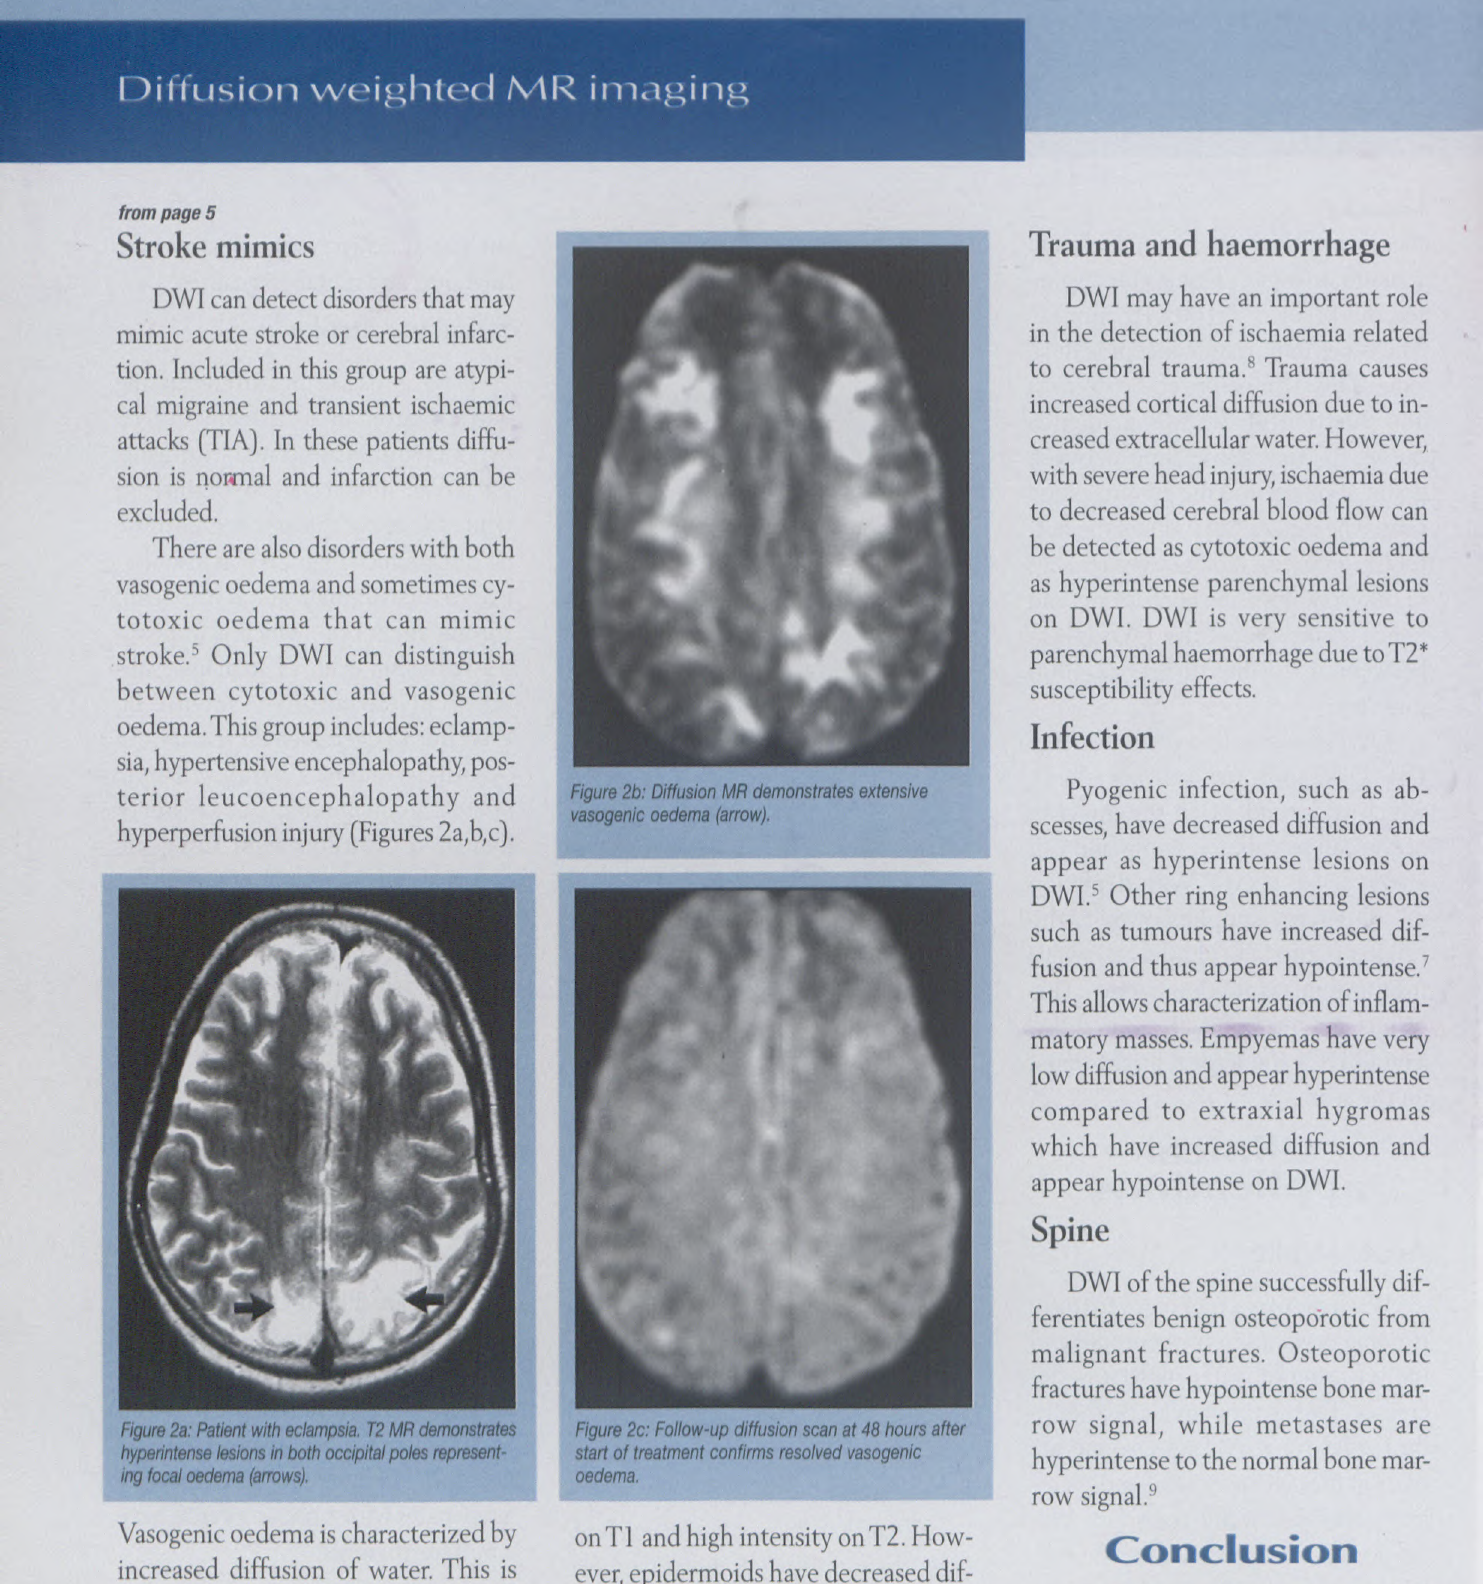
Figure 28: Patient with eclampsia. T2 MR demonstrates hyperintense lesions in both occipital poles represent- ing focal oedema (arrows).